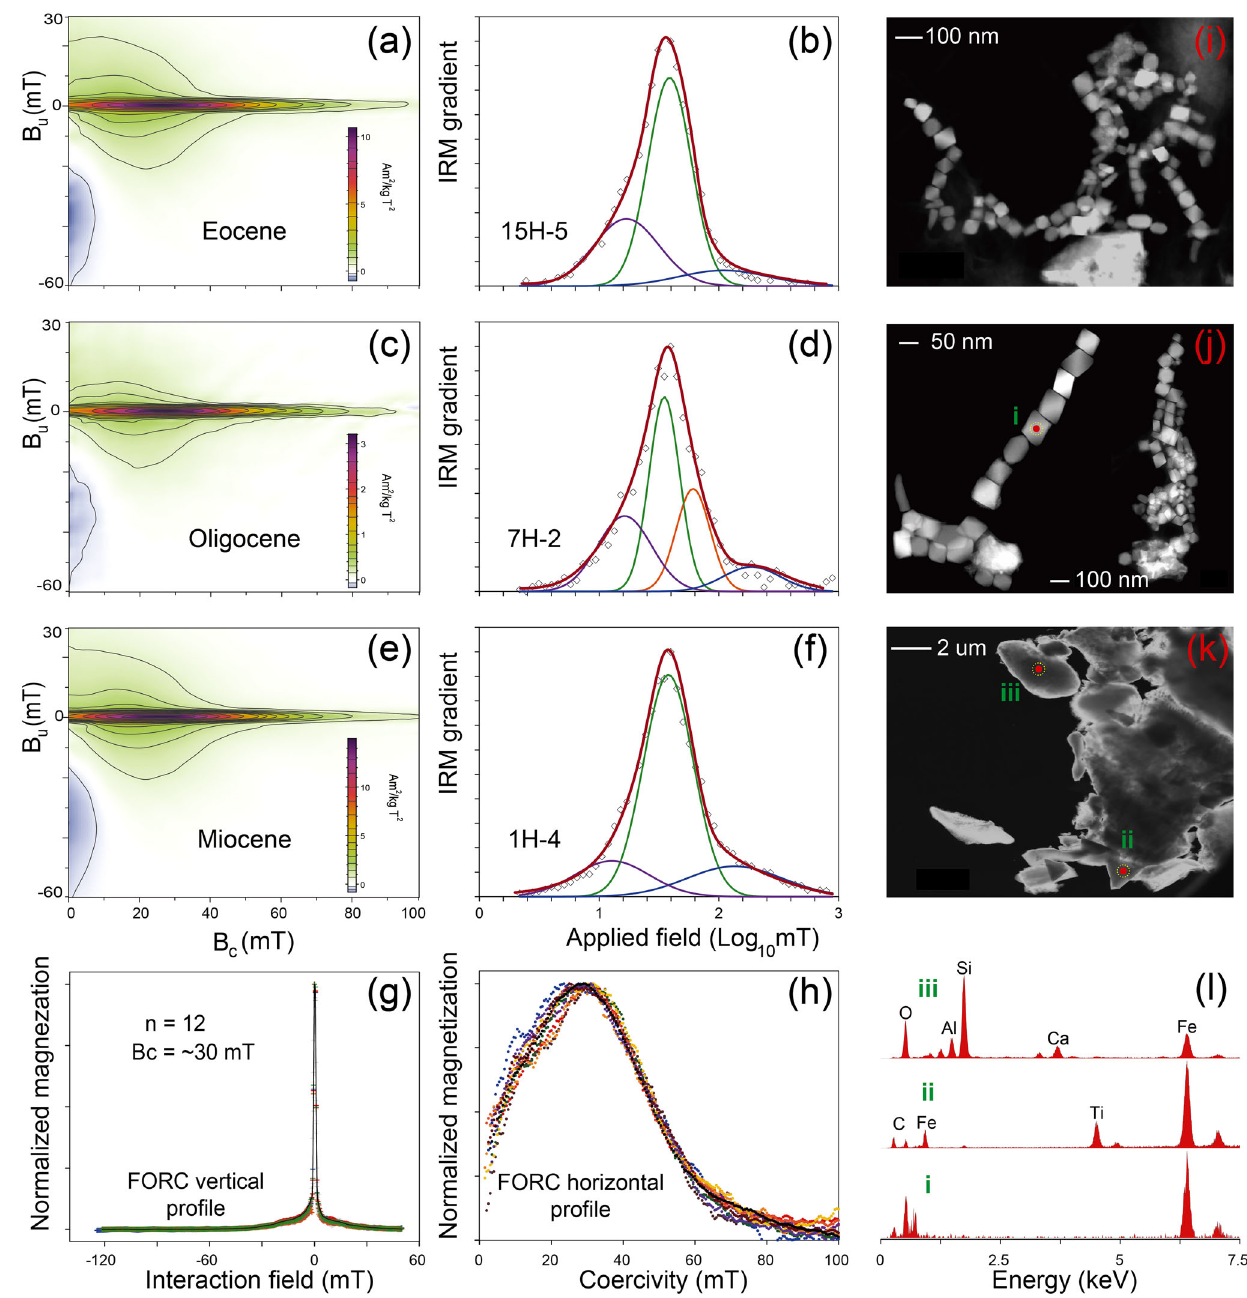
Fig. 2 Magnetofossil identi fi cation using magnetic and TEM analysis. a – f FORC diagrams and IRM component analysis for representative Eocene, Oligocene, and Miocene samples. The derivative of IRM acquisition curves is plotted as open diamond symbols. Fitted components have different colors: red, sum of fi tted components; green and orange, biogenic soft and hard magnetite, respectively, with narrow distributions; purple and blue, low- and high- coercivity detrital magnetic assemblages with broader distributions, respectively (for more details see Supplementary Table 1). g , h Vertical and horizontal pro fi les of FORC diagrams, respectively, for selected samples. i – l TEM images and EDXS analyses (numbered dots) of magnetofossils with different morphologies and irregularly shaped eolian dust